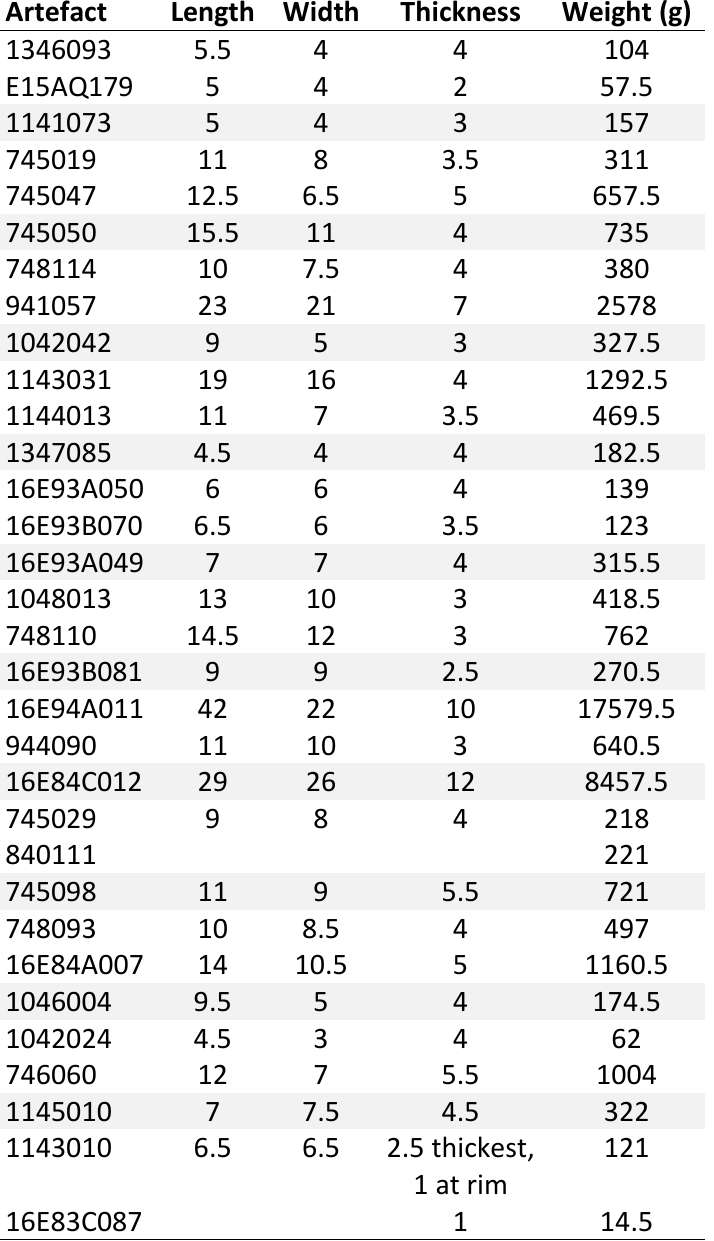
Table 3. Metric data of basalt ground stone artefacts. Units are centimeters and bold font indicates intact